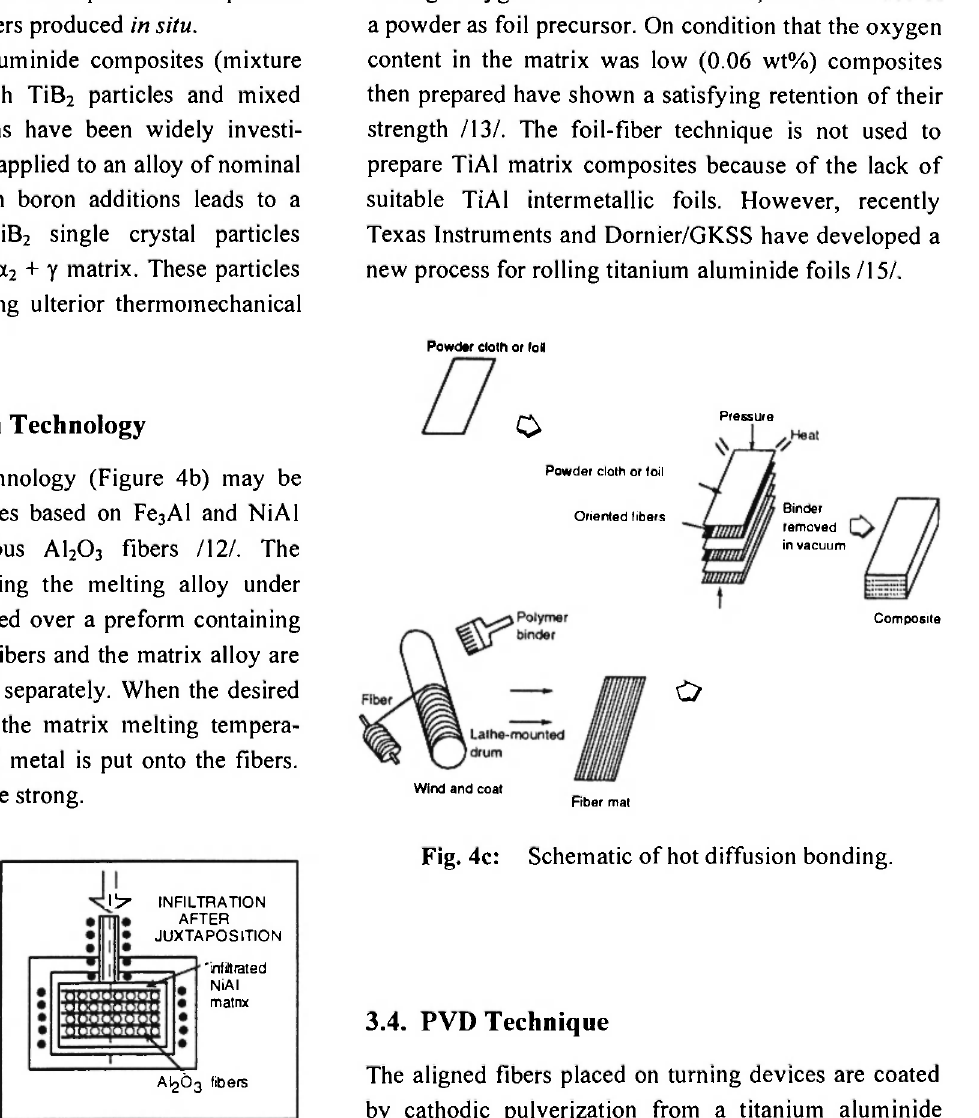
Fig. 4b: Schematic of liquid infiltration